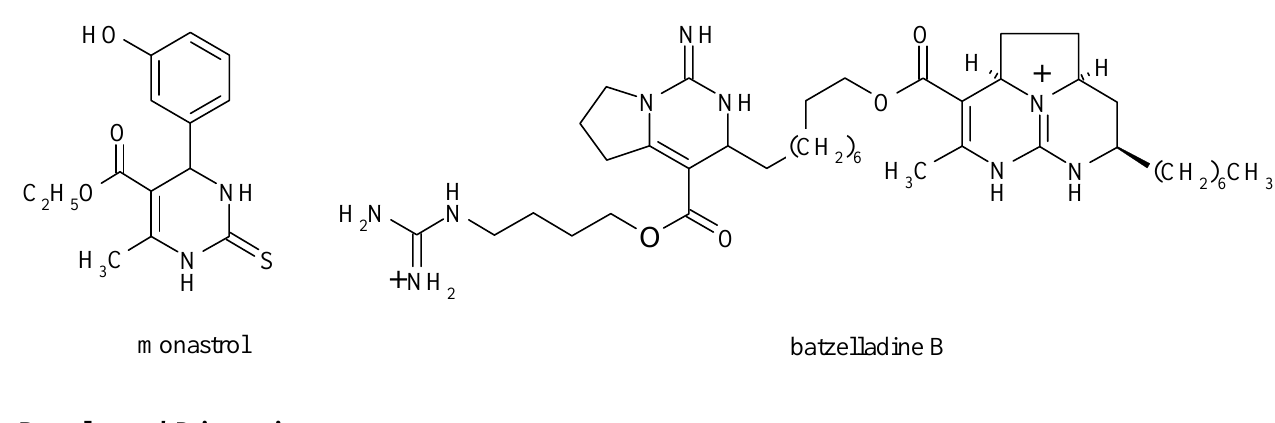
Figure 1 . Examples of biologically active